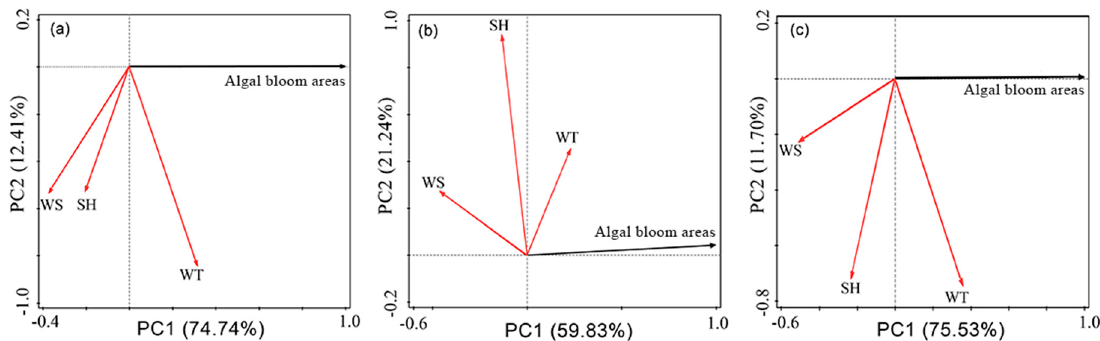
Figure 13. Principal component analysis (PCA) ordination diagram of daily algal blooms in Lake Dianchi. ( a ) 2000–2005; ( b ) 2006–2015; and ( c ) 2016–2018. Dianchi. ( a ) 2000–2005; ( b ) 2006–2015; and ( c )